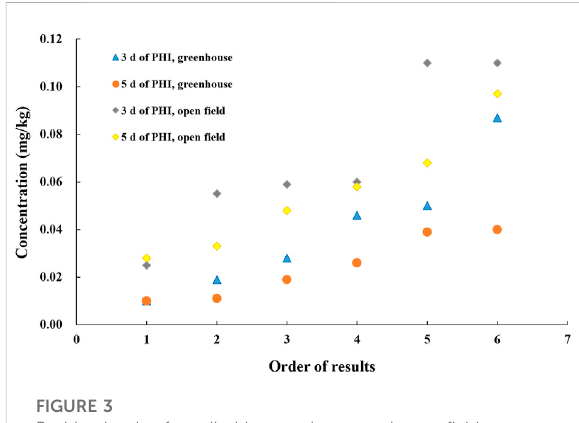
FIGURE 3 Residue levels of oxadixyl in greenhouse and open fi eld cucumbersondifferentPHI(12samplesfromdifferentexperiment sites, in the order of smallest to largest in the residue